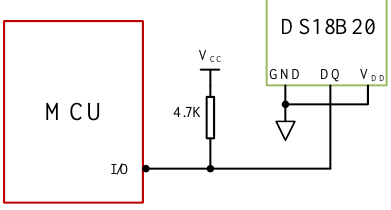
Figure 5. Diagram of DS18B20 parasitic power supply.